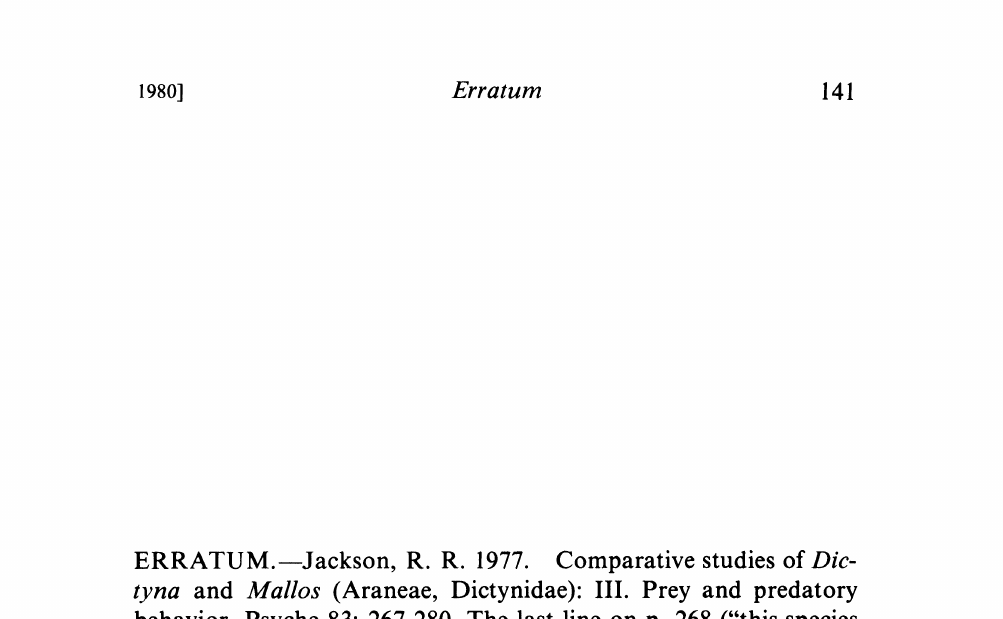
the last line on p. 269. Thus the text should read: "Most of the observations of feeding (88%) for this species came from spending many hours observing a particular web complex, located in a culvert through which a creek passed in the Chiracahua Mountains of